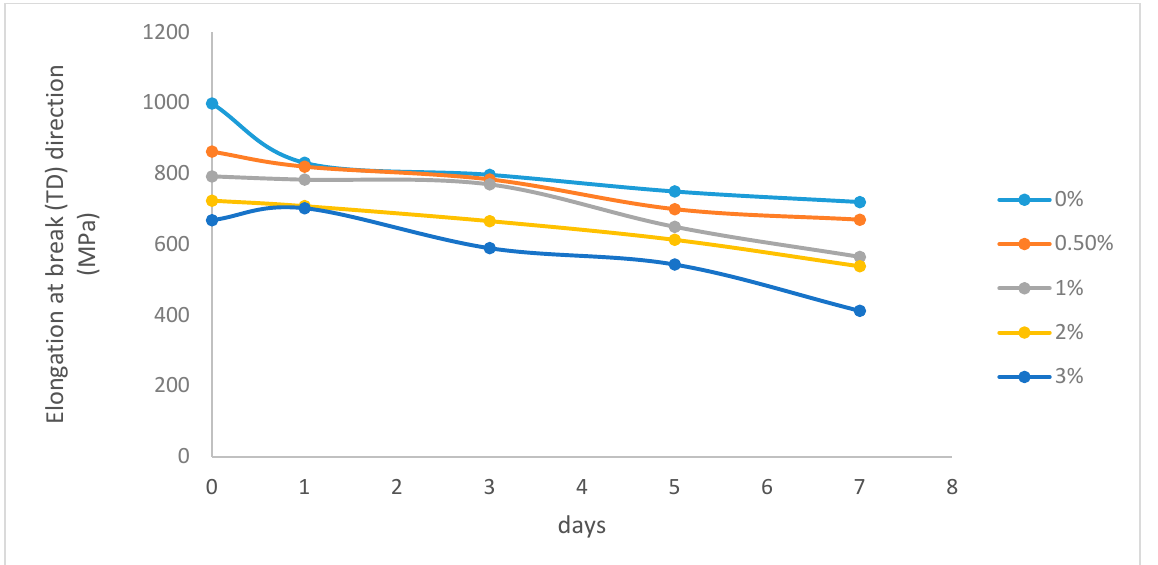
Figure 6. Changes in elongation at break in transverse direction (TD).